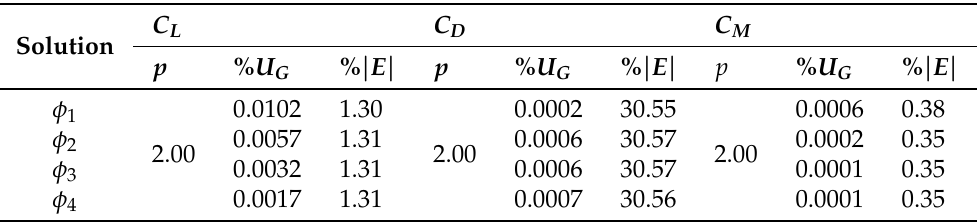
Table 25. Uncertainty estimations for H-mesh with varying wake node distributions (log 2, 1,0,1) based on mesh dependency. − −